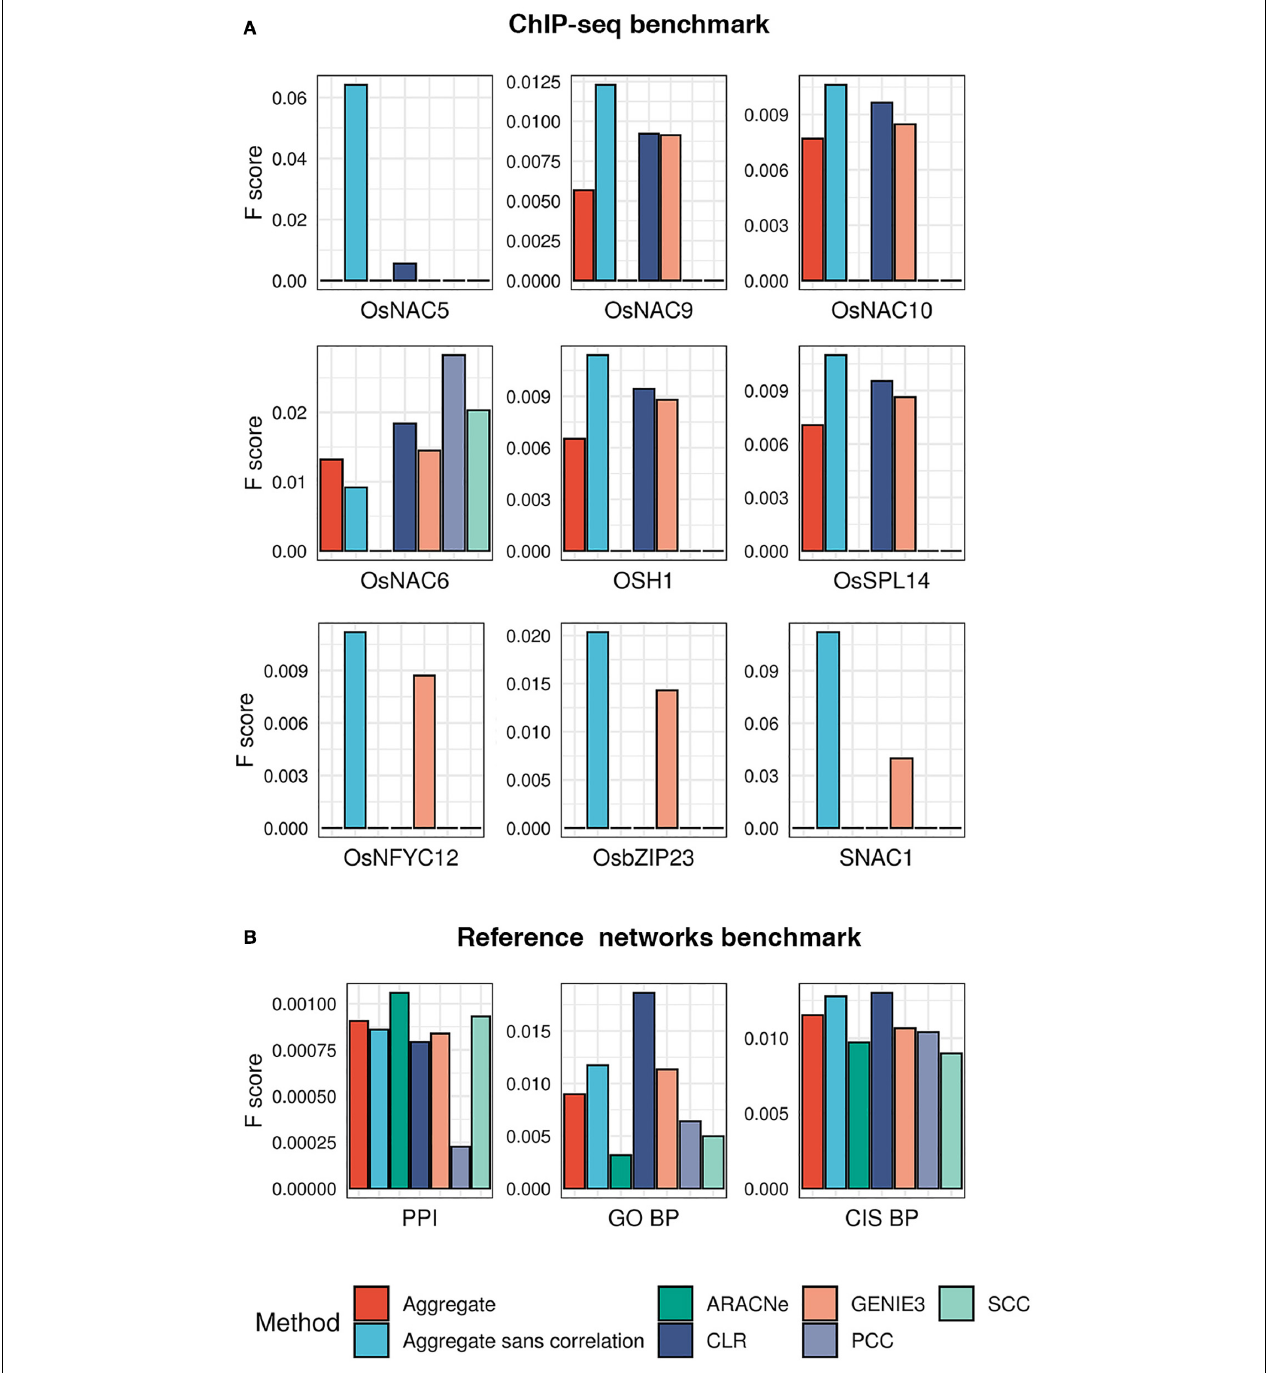
FIGURE 3 | Evaluation of the five network prediction algorithms and their aggregate. (A) A ChIP-seq benchmark for 9 TFs was created from publicly available datasets. For each of these 9 TFs, we checked the overlap between experimentally validated targets (ChIP-bound genes) and network-predicted targets (genes predicted by each of the five algorithms in our ensemble). This evaluation was also made for the consensus network obtained by statistically aggregating the predictions from the five algorithms. Each bar plot shows F1 scores ( y axis; a measure of performance, the higher the better) of each algorithm ( x axis) in correctly predicting ChIP-targets of TFs. (B) Due to the unavailability of experimentally validated targets of a large number of TFs in our network, we created additional ‘reference networks’ to gauge the quality of the inferred networks. PPI, reference network derived from the predicted protein–protein interaction network of rice (PRIN database); GO BP, reference network derived from co-annotations in select gene ontology biological process terms; and CIS BP, reference network obtained by utilizing the available putative DNA-binding sites of TFs in the CIS BP database (see “Materials and Methods” for details). The bar plots of F1 scores shows the performance of each algorithm in reconstructing the reference